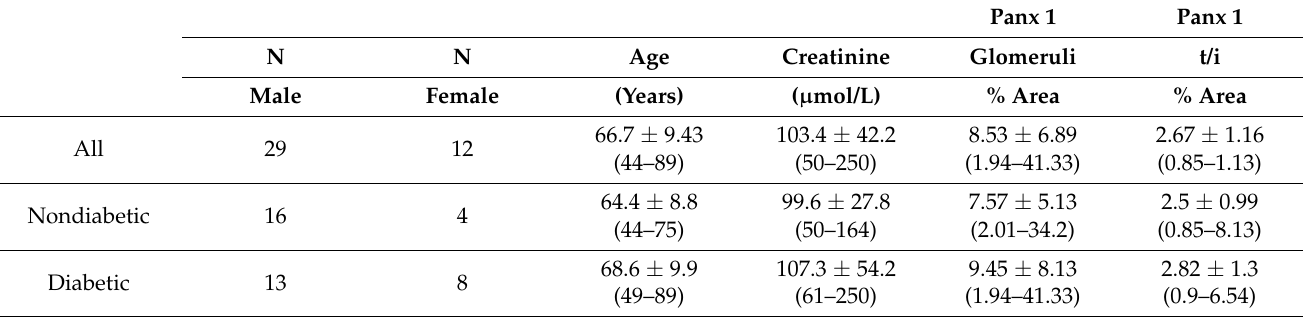
Table 2. Patient age, sex, serum creatinine, and expression of Panx1 in glomeruli and tubules.